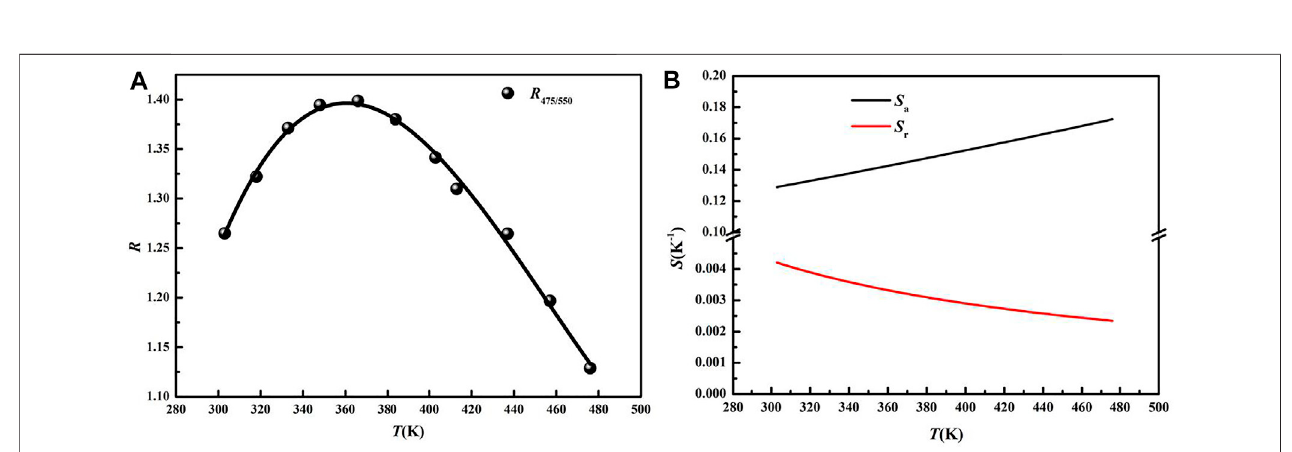
FIGURE 6 | (A) Temperature-dependent R 475/550 ; (B) S a and S r from 303 – 476 K.